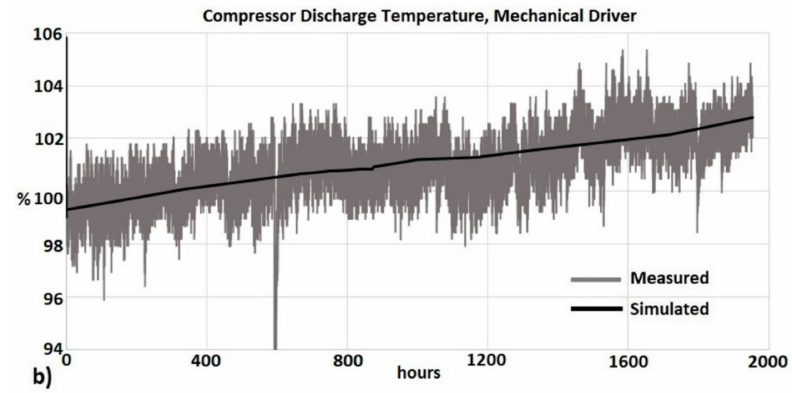
Figure 7. Measured and simulated compressor discharge temperatures: ( a ) power generator; ( b ) mechanical driver.